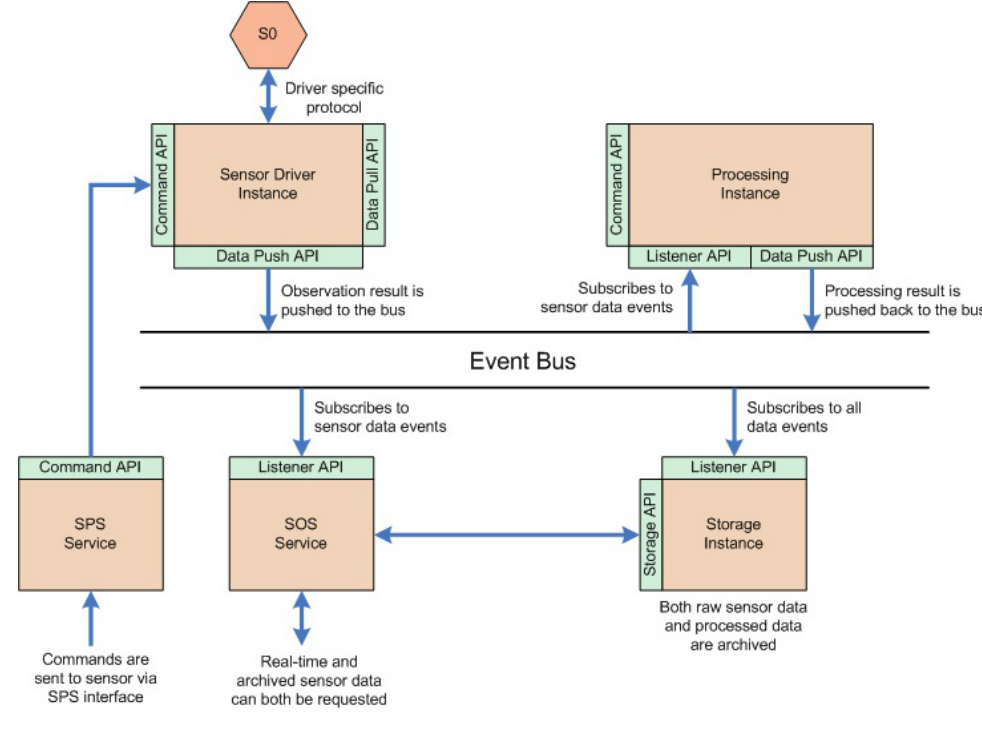
Fig. 7 Storage module structure